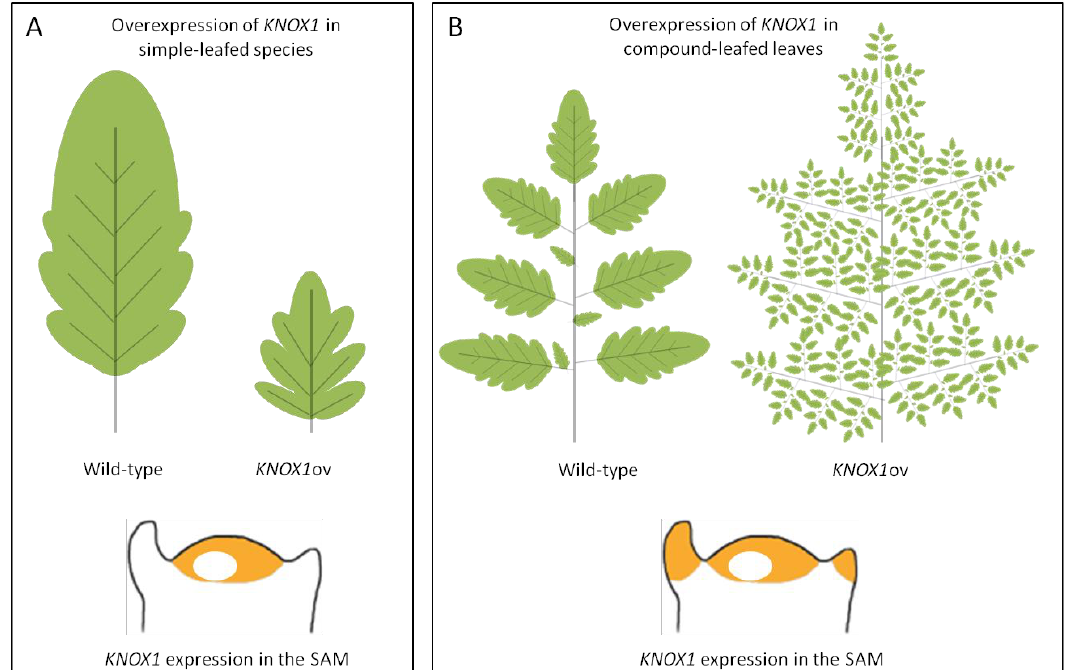
Figure 3. Overexpression of KNOX1 genes in plants with simple or compound leaves. Schematic representation of the lobed leaf phenotype of Arabidopsis plants that overexpress KNOX1 genes ( A ) or the supercompound leaf phenotype due to KNOX1 overexpression in tomato ( B ). In the lower part of the panels the expression of KNOX1 genes in the shoot apical meristem (SAM) of plants with either simple ( A ) or compound ( B ) leaves is schematized. KNOX1 expression domains are shown in